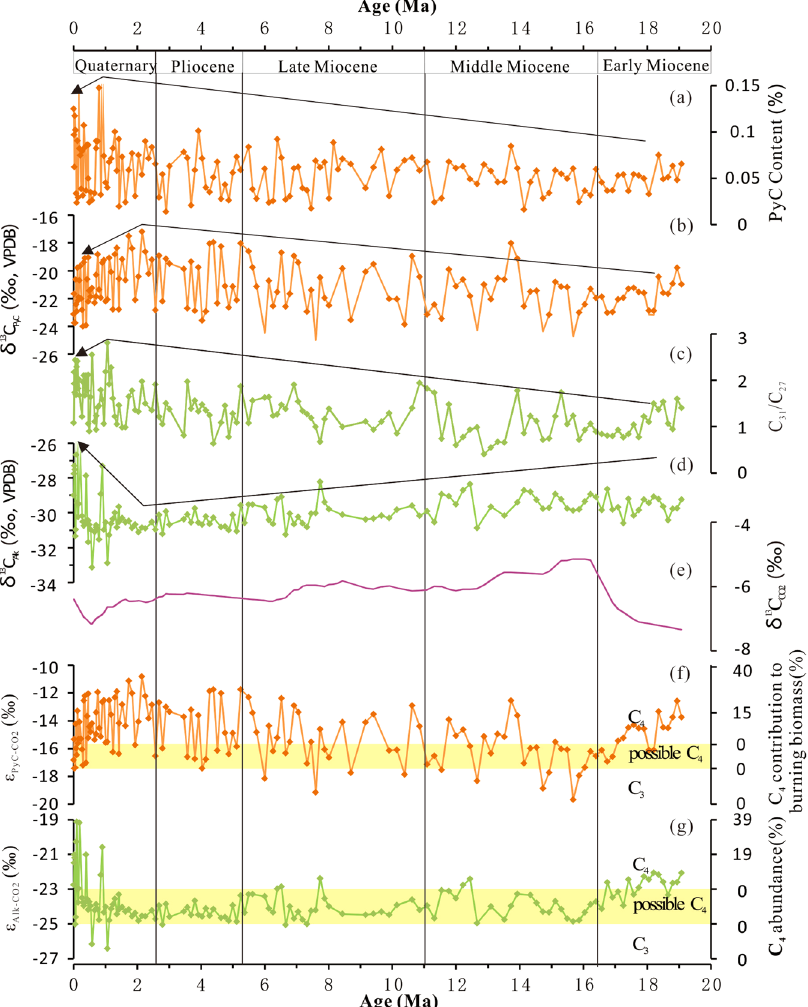
Figure 2. Abundance and carbon isotope composition data from n -alkanes and pyrogenic C (PyC) from ODP core 1146: ( a ) PyC content; ( b ) δ 13 C values of PyC ( δ 13 C PyC ); ( c ) C 31 /C 27 n -alkane ratio; ( d ) Average δ 13 C values of long-chain n -alkanes ( δ 13 C Alk ); ( e ) Record of δ 13 C of atmospheric CO 239 ; ( f ) The contribution of C 4 taxa to combusted biomass based on carbon isotopic enrichment factor for PyC ( ε PyC-CO2 ); ( g ) C 4 abundance based on carbon isotopic enrichment factor for n- alkanes ( ε Alk-CO2) . Arrows indicate the overall trend in proxies. Two yellow bars show the area of uncertainty in reconstructing the relative prominence of C 3 and C 4 taxa based on ε ε PyC-CO2 and Alk-CO2 , and thus the basis for the very conservative estimates of prominence of C 4 taxa mentioned in the text of this